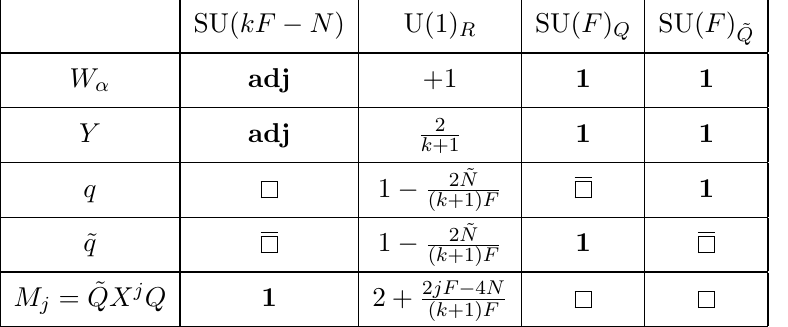
˜ ˜ N ) ( N = kF − N ) SQCD with an